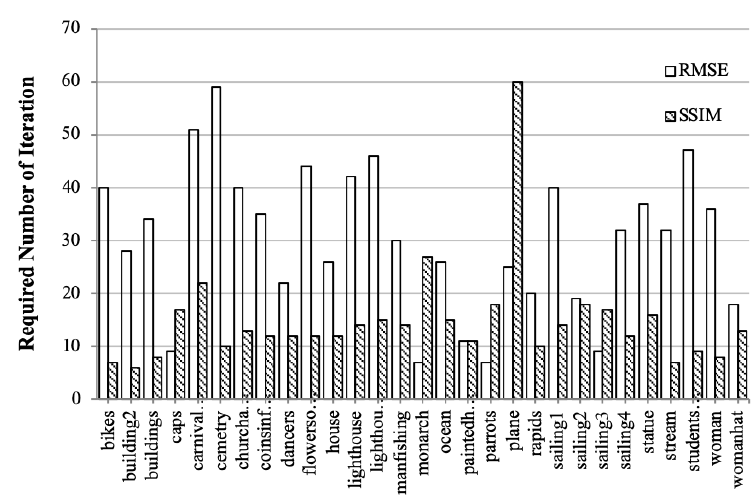
Figure 10. The required number of iterations to reach the convergence for the Fienup algorithms based on RMSE and SSIM.